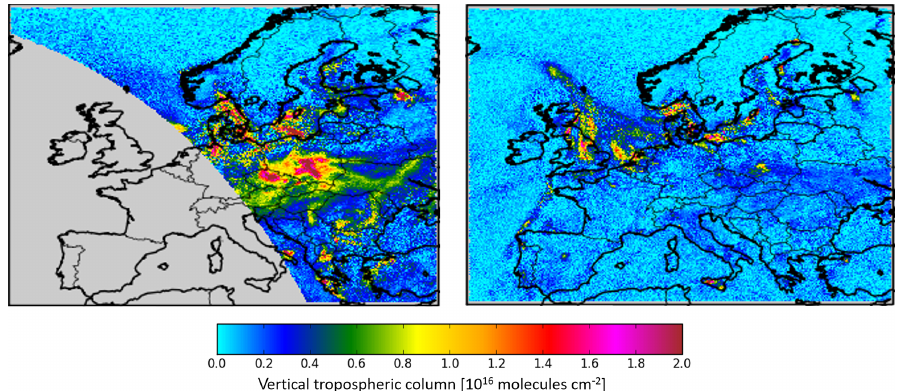
Figure 4. Example of two S4 NO 2 scenes: early morning at 04:00UTC and midday at 12:00UTC, on 1 June 2003. Data is plotted for solar zenith angles < 85 ◦